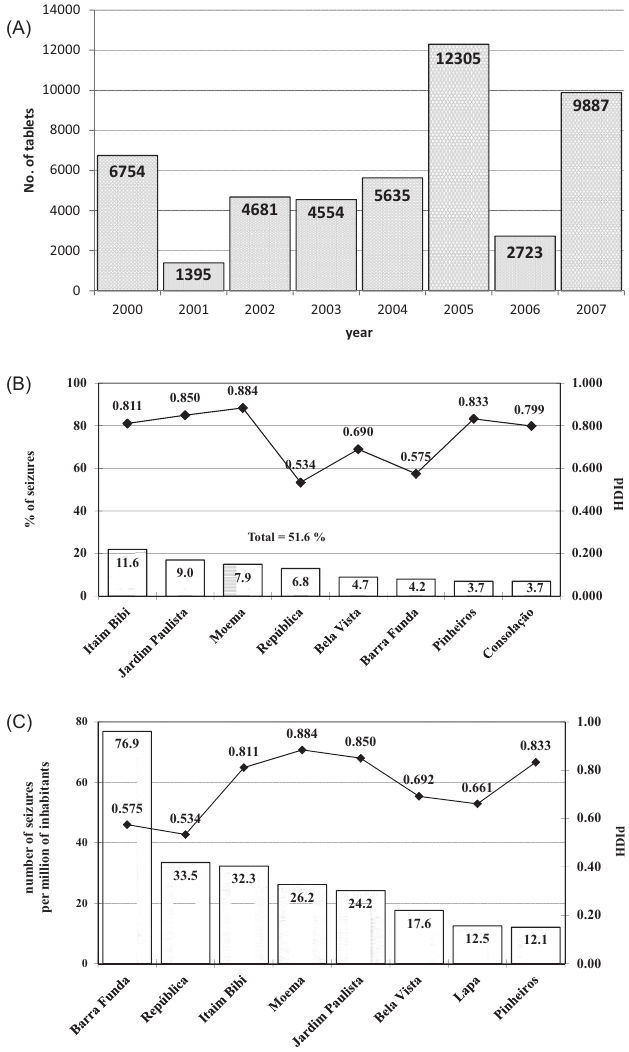
FIGURE 1 - Ecstasy tablets seized in the municipality of São Paulo from 2000 to 2007. (A) Total number per year; (B) Top ranking districts according to percentage of seizures and their corresponding HDI (HDId); (C) Top ranking districts according to number of seizures per million of inhabitants and their corresponding HDI